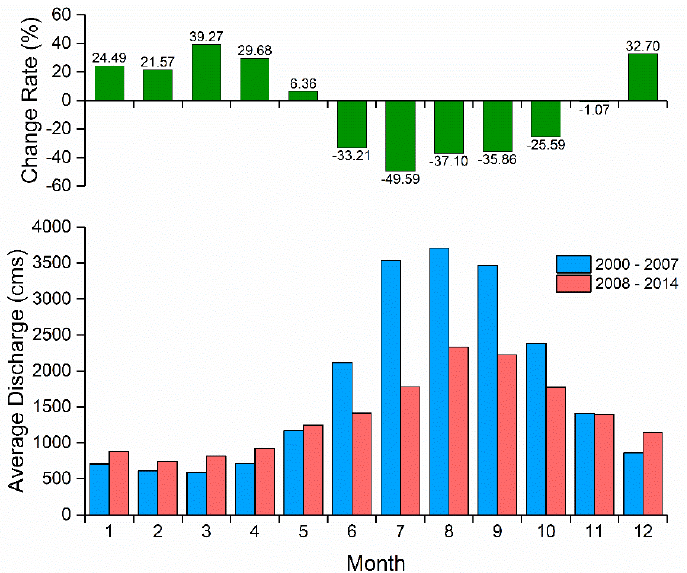
Figure 10. Intra-annual Variation in Runoff Measured at the Yunjinghong Hydrological Station before and after 2008.